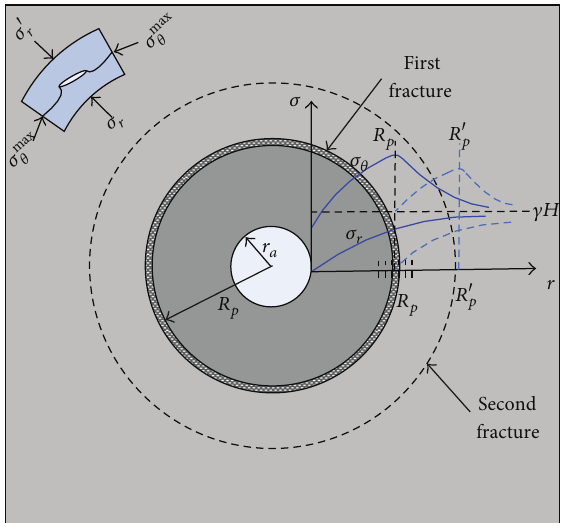
Figure 19: Elastoplastic geostress fields in surrounding rock mass and forming process of zonal